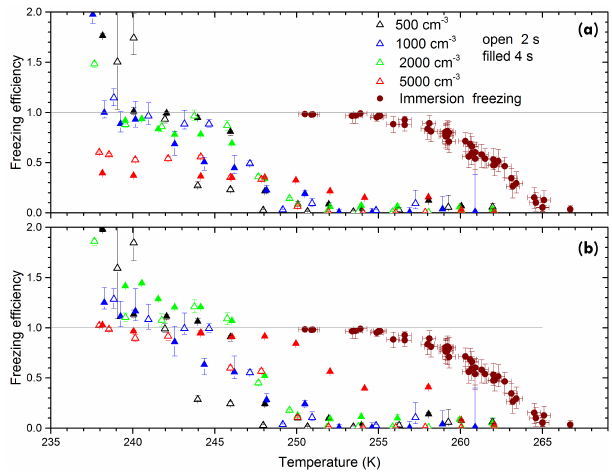
Figure 4. Freezing efficiency FE against chamber temperature for contact freezing experiments (triangles) with 200nm diameter AgI particles with droplet residence times of 2s (open symbols) and 4s (filled symbols). The concentration of silver iodide particles varies from 500 to 5000cm − 3 . A collision efficiency CE = 0 . 13 is used to calculate N . FE is calculated using Eq. (1) in panel (a) and Eq. (4) in panel (b) . Immersion freezing of droplets in the ZINC chamber for a 3s residence time is shown as circles. The gray horizontal line indicates the maximum freezing efficiency realized when the first collision initiates